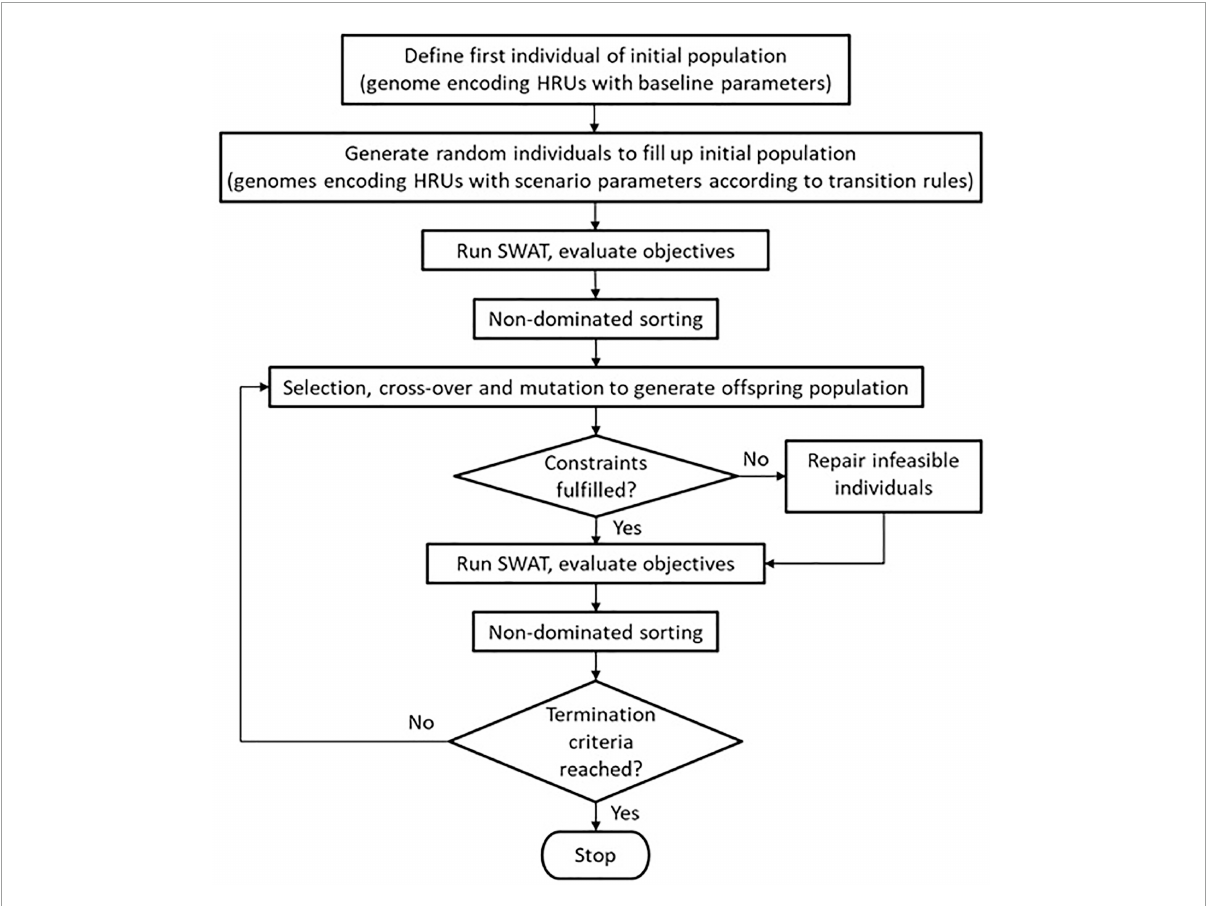
FIGURE2 Flow chart of the CoMOLA optimization process for SWAT